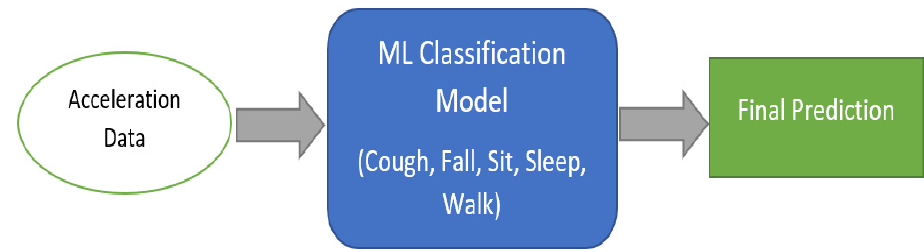
Figure 3. Regular ML classification model.